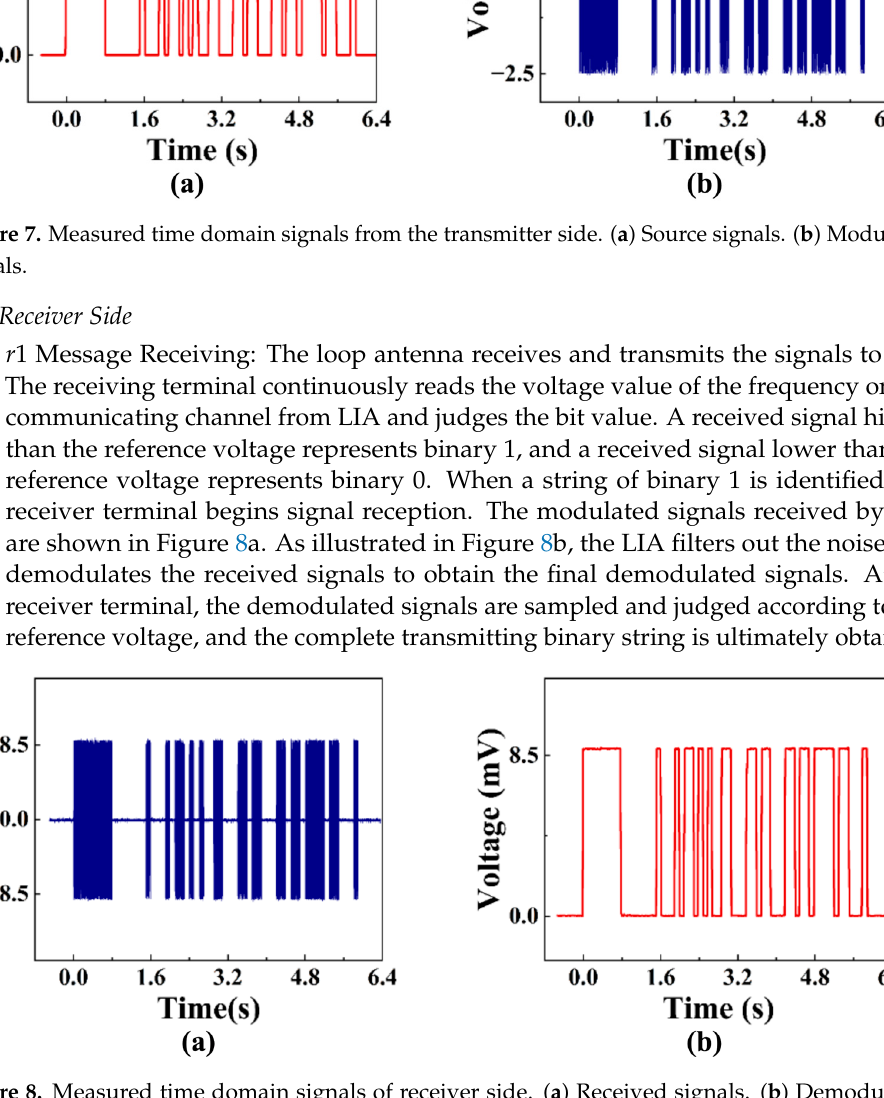
Figure 8. Measured time domain signals of receiver side. ( a ) Received signals. ( b ) Demodulated signals.